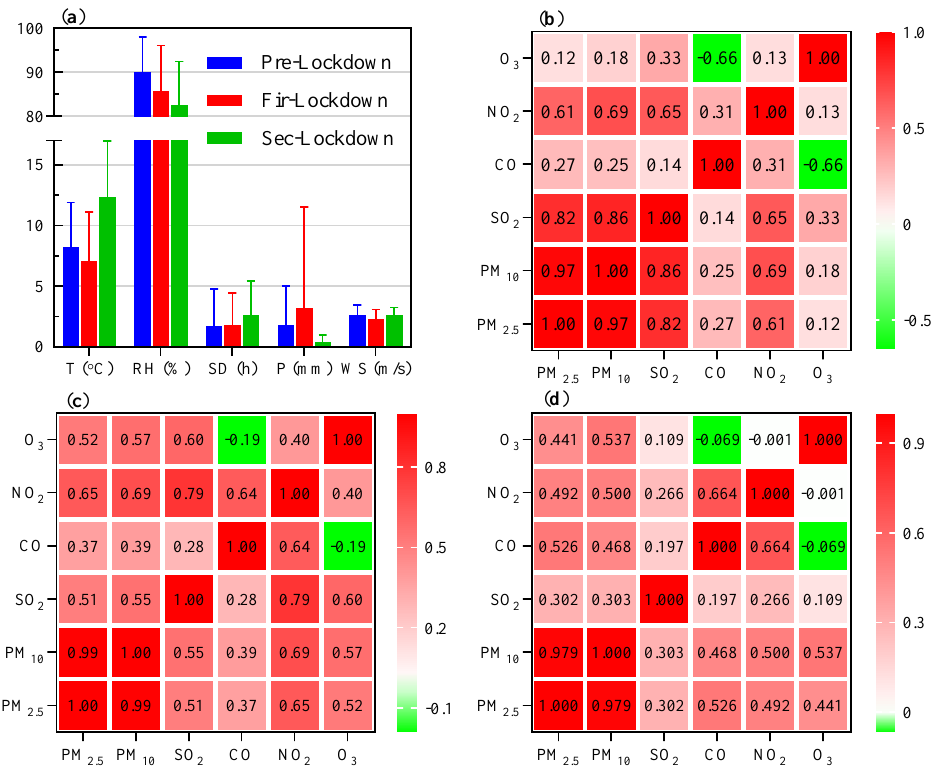
Figure 5. ( a ) Comparison of mean meteorological parameters during the Pre-Lockdown, Fir-Lockdown, and Sec-Lockdown stage, error bars indicate the standard deviations over multiple days. ( b – d ) Correlation heat map among daily mean concentrations of pollutants during the Pre-Lockdown, Fir-Lockdown and Sec-Lockdown period, respectively.